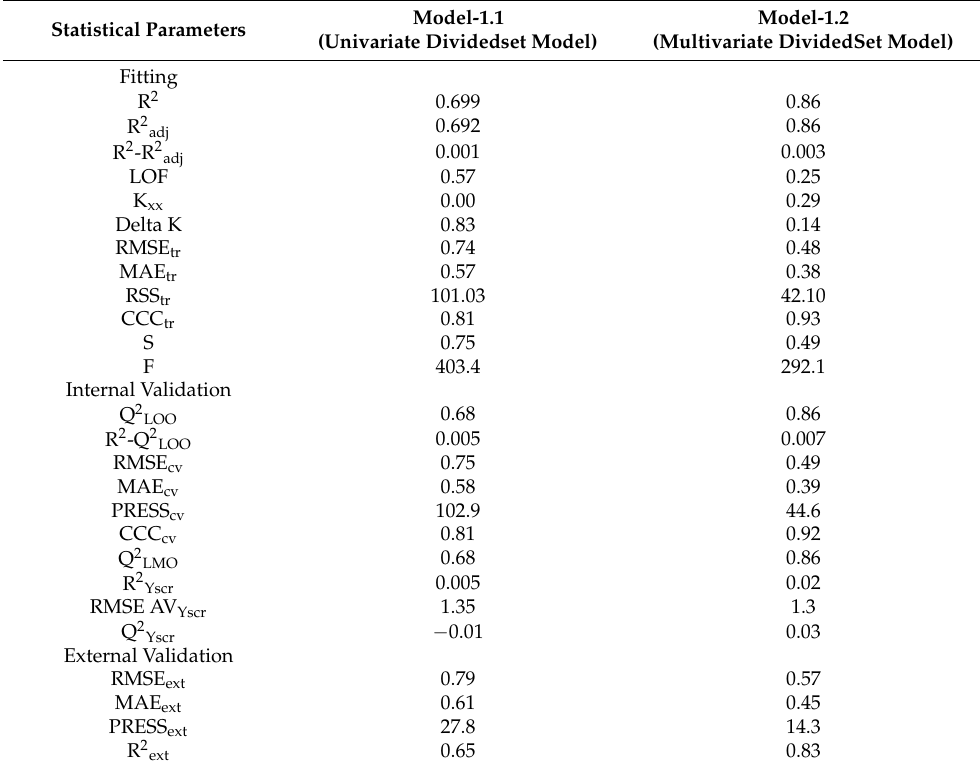
Table 1. The statistical parameters connected with the fitting, double validation and Y-scrambling for models 1.1 and